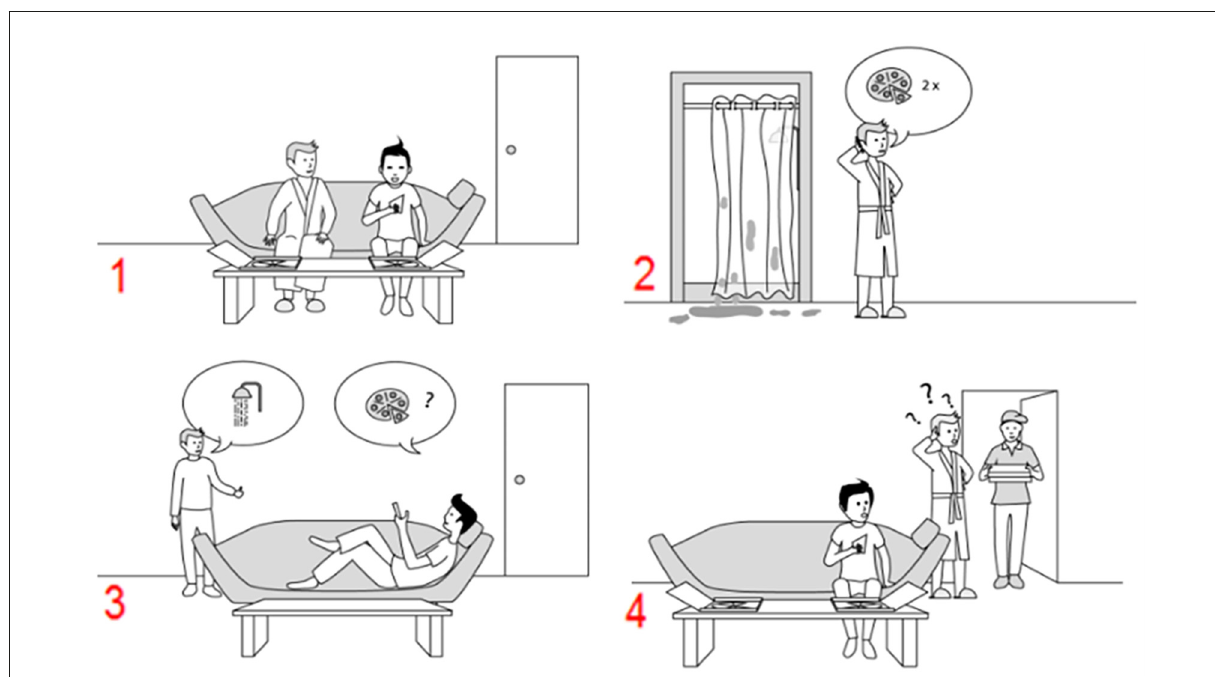
FIGURE1 An example of a false belief sequence in the picture sequencing task (the correct order is 3-2-1-4). Participants have to select, in the correct order, the first picture on the screen, then the second picture, and so on. After each selection, the pictures move in the order indicated by the participant (Heleven et al.,